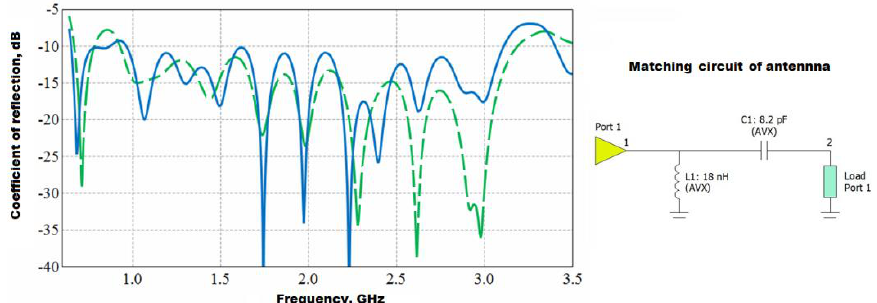
Fig. 8. The dependence of the reflection coefficient at the input of the Vivaldi antenna on frequencies (solid line - basic design from Antenna Magus, dashed line - optimized matching circuit at Optenni